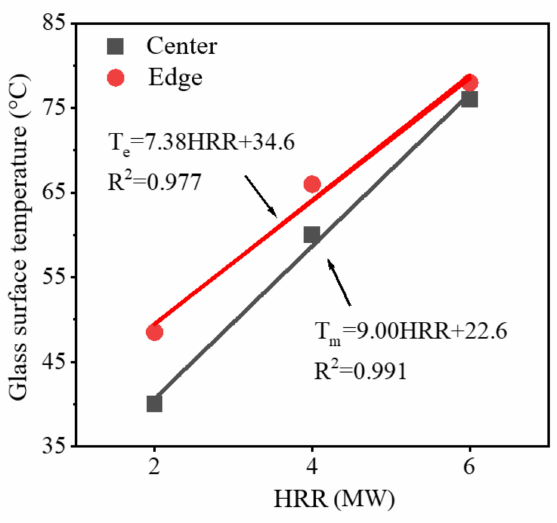
Figure 32. Correlation between HRR and the glass surface